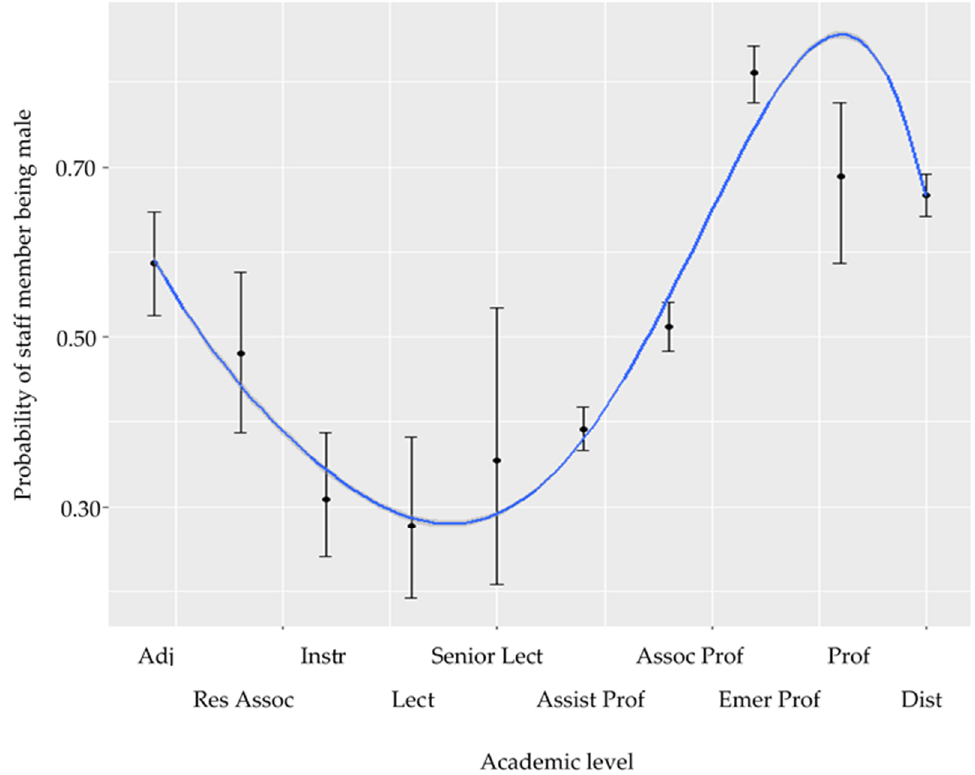
Figure 4. Modelled probabilities of a staff member being male as a function of academic level in the USA/Canada region. The modelled polynomial term (blue line) is also plotted which includes the standard error (dark grey).